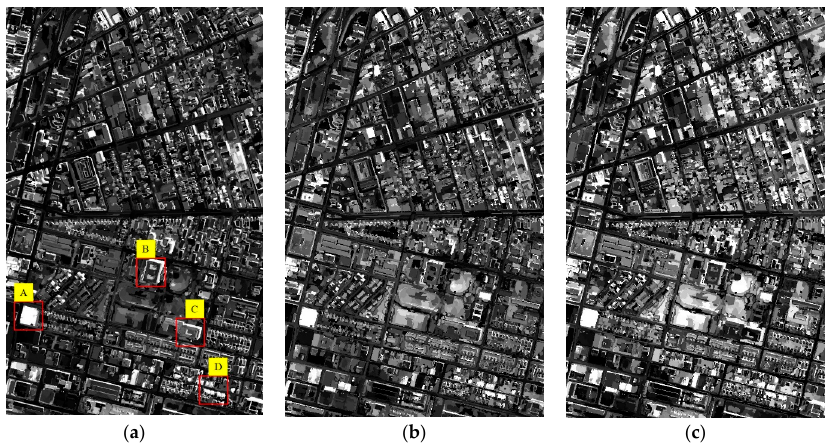
Figure 11. Change intensity images obtained by ( a ) supervised MAD, ( b ) unsupervised MAD, and ( c ) stack PCA. Higher values in the image indicate the higher probability to be changed. The four red rectangles and yellow labels indicate the zoomed areas shown in Figure 12 below.